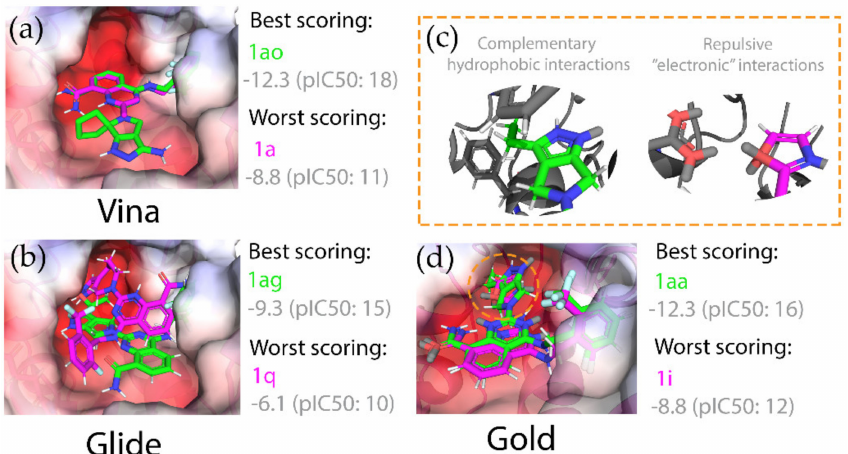
Figure 8. Comparisons of binding modes between the best (green) and worst (magenta) ranked compounds for ( a ) Vina, ( b ) Glide, and ( c , d ) Gold. In all cases, the best and worst scoring compounds were examples of low and high-a ffi nity binders, respectively. Gold uses pseudo-atoms which represent lone pairs (for hydrogen bonding), which are represented as grey atoms. For Vina and Gold, the common sca ff old of the inhibitors (Figure 5) were docked similarly. Top scoring compounds from these programs contained bulky R 2 groups, which made favorable hydrophobic interactions with the surface of the